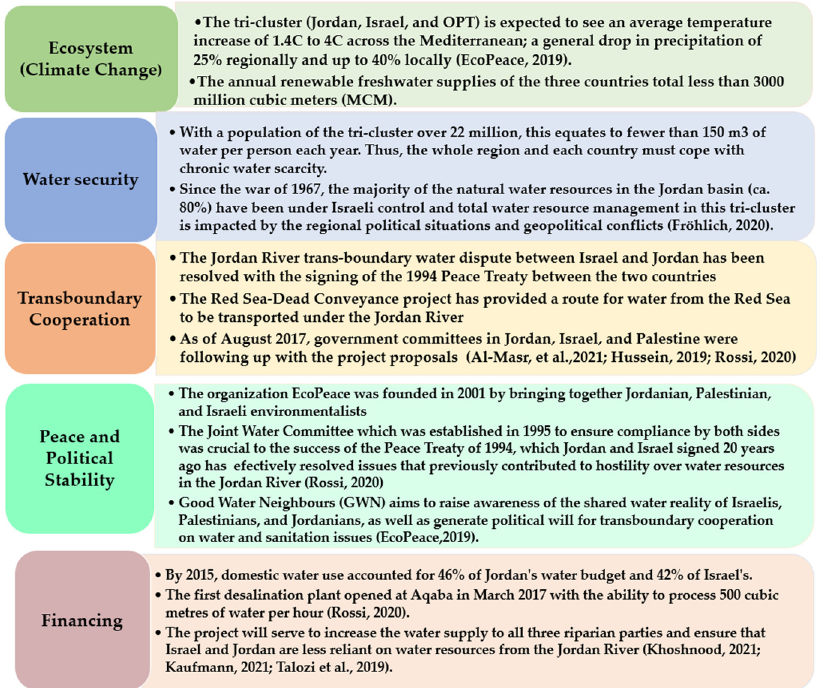
Figure 3. Overview of trends and patterns of selected water security dimensions from the UN Water’s 2013 conceptual framework, with a spotlight on transboundary or cross-water sharing and allocation aspects included (source: created by authors using various data sources) [12,17,22,27,44,45,52,53] .